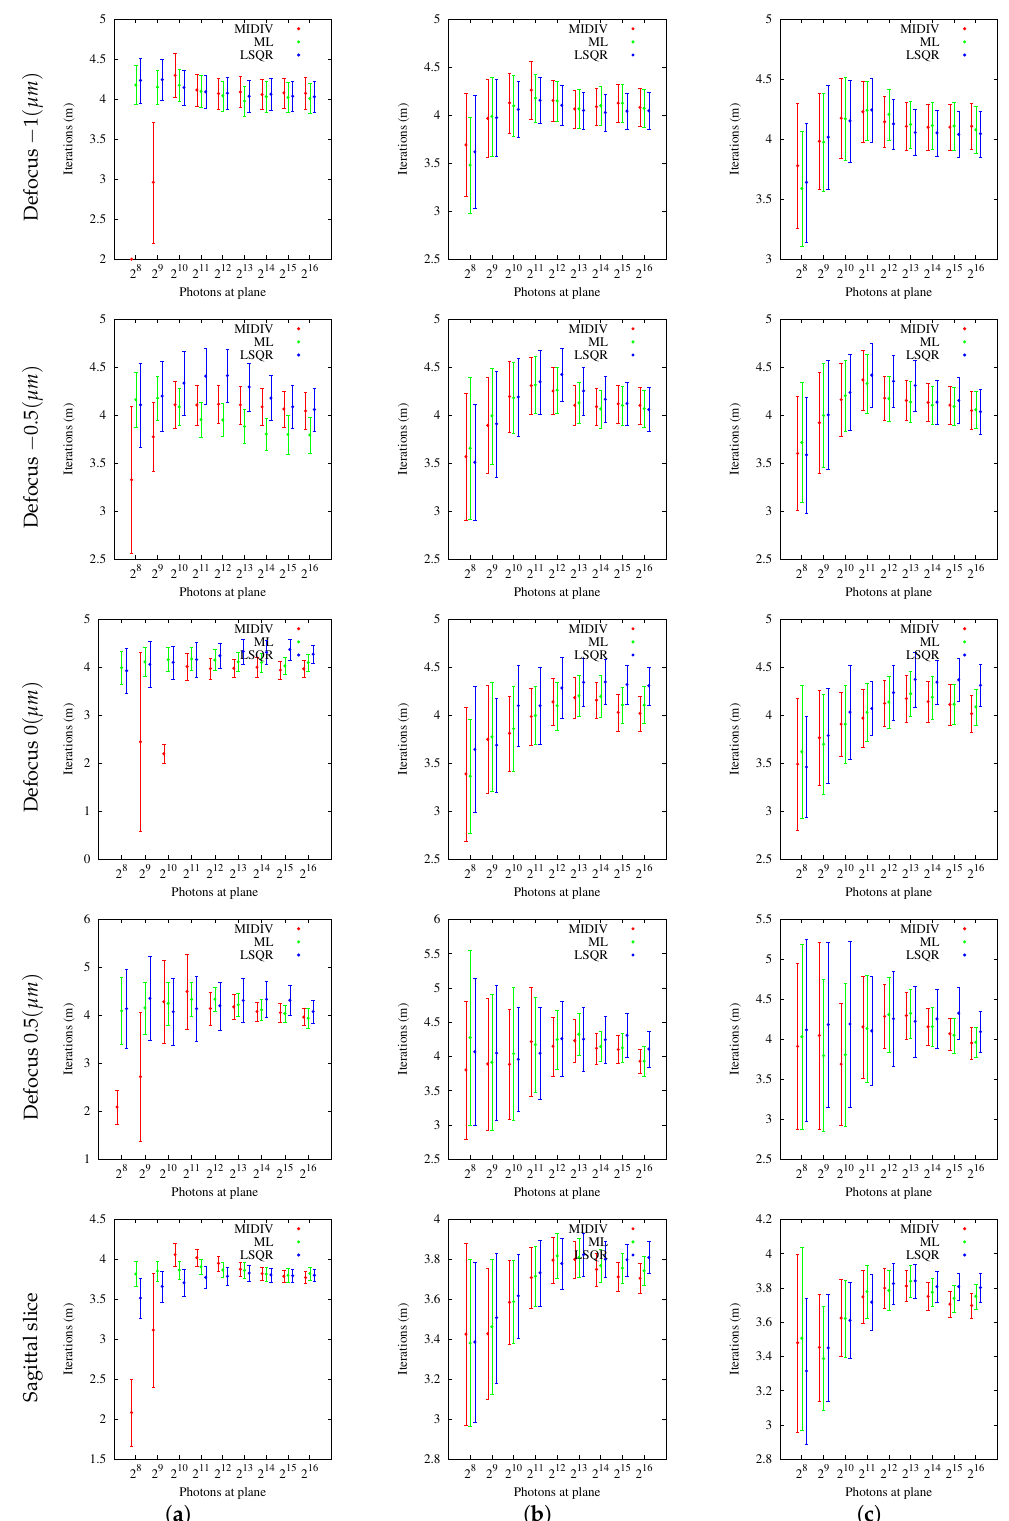
Figure 6. Iteration measurements of the methods: MIDIV (red), ML (green) and LSQR (blue). Iteration number results are presented as the mean point estimates of the iteration number and their confidence intervals. ( a ) NCI; ( b ) NCII; ( c )